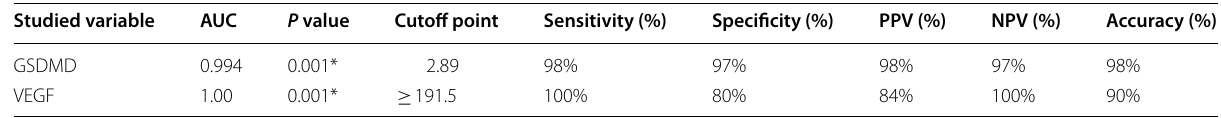
Table 4 Diagnostic accuracy of GSDMD (in the detection of exudative pleural effusion and VEGF (in the detection of malignant pleural